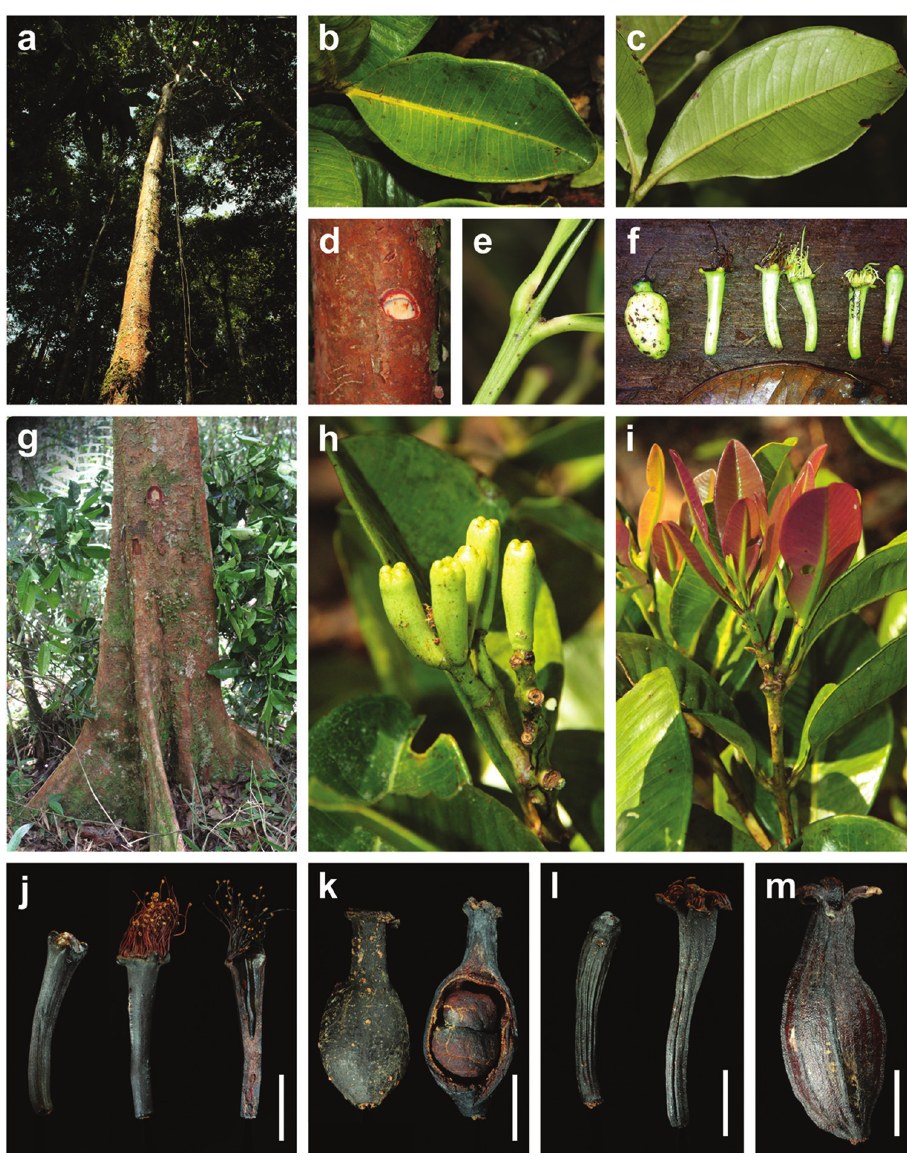
Figure 1. Morphological characters of Syzygium balgooyi and S. schumannianum . Syzygium balgooyi ( a–k ): a c. 20 m tall trunk b upper leaf surface; c lower leaf surface d bark with slash e ridged shoot apex with subopposite leaves f flowers at different stages during anthesis and fruit g trunk base with steep narrow buttresses h inflorescence with flower buds i shoot with young leaves j dried flowers before and during anthesis and longitudinal section of flower k dried fruit and longitudinal section of fruit showing two coty- ledons. Syzygium schumannianum ( l–m ): l dried flowers before and during anthesis m dried fruit. a–b